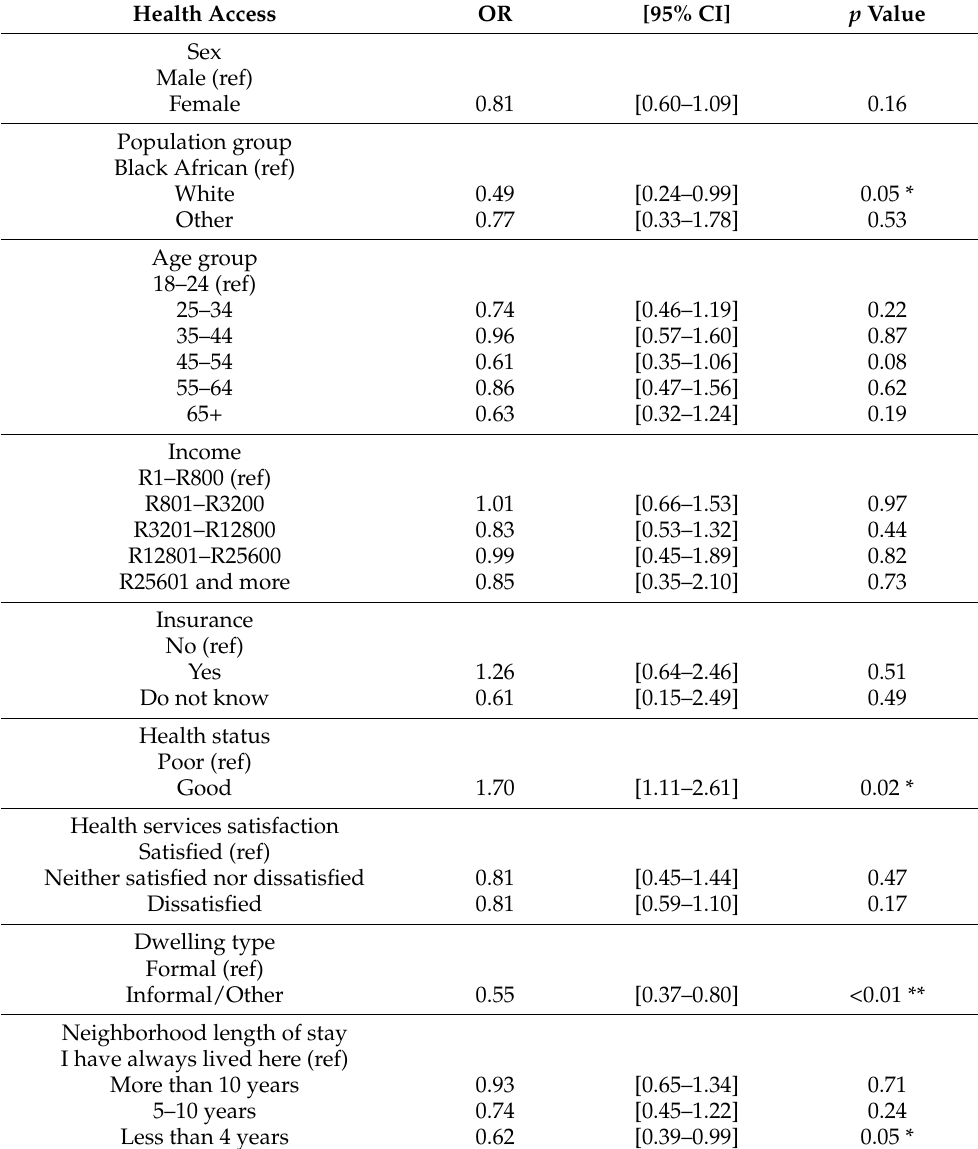
Table 4. Multivariate logistic regression model of factors affecting access to public healthcare facilities. Health Access OR [95% CI] p